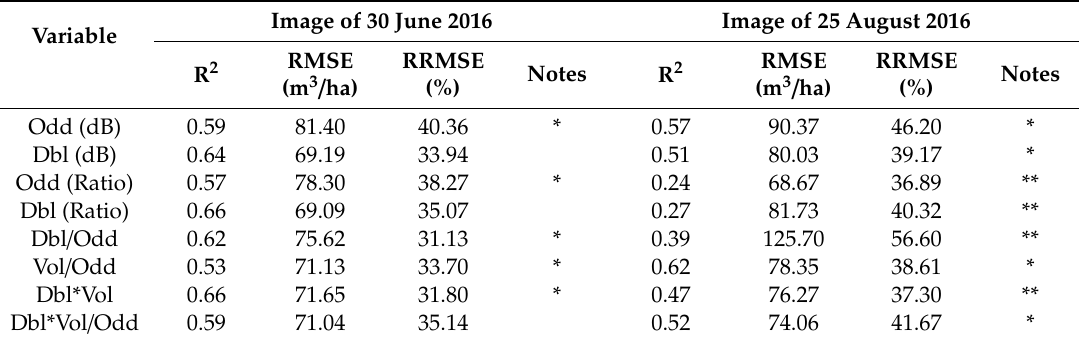
Table 5. The GSV estimation accuracy of the selected variables (Note: * and ** indicate the percentages of the plots with errors exceeding the threshold are larger than 10% and 20%,